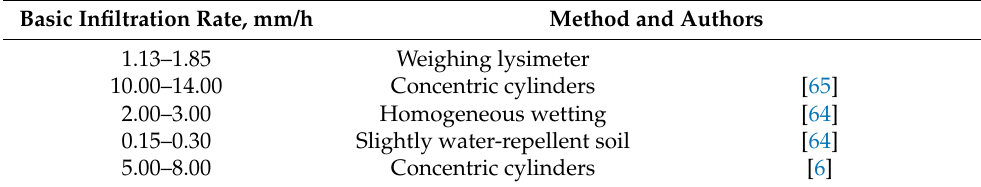
Table 4. Values of the infiltration rate of a silty loam soil.